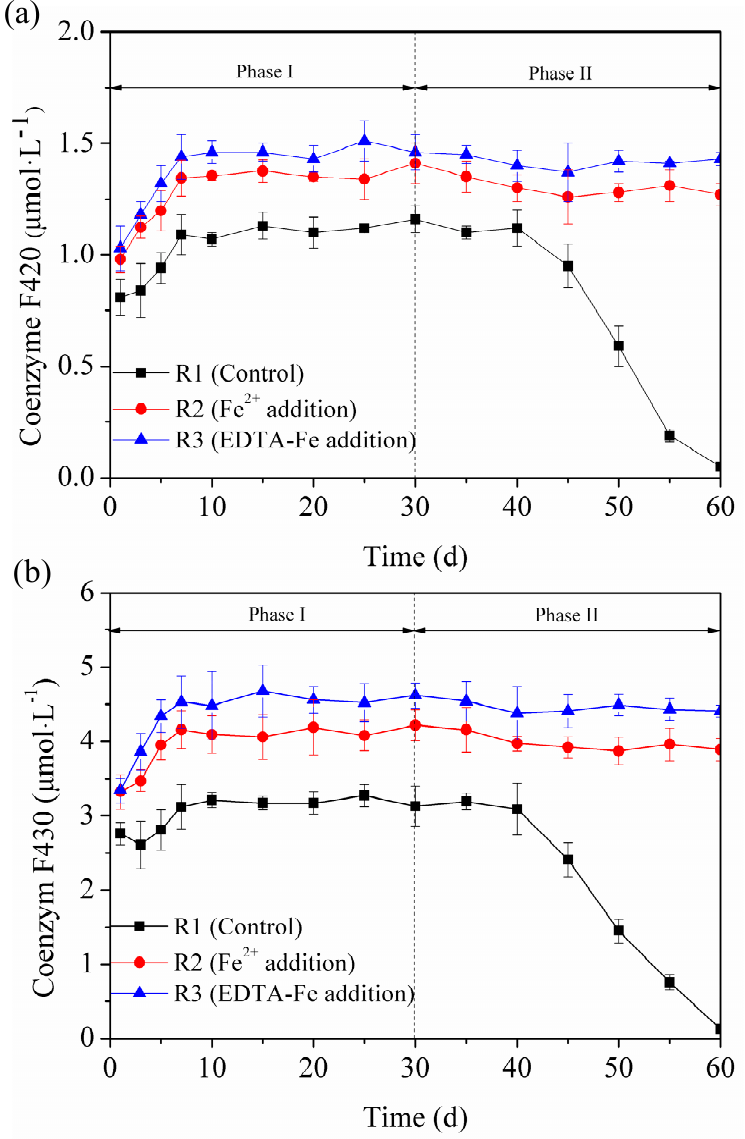
Figure 3. Changes in coenzymes ( a ) F420 and ( b ) F430 with di ff erent additives and operating